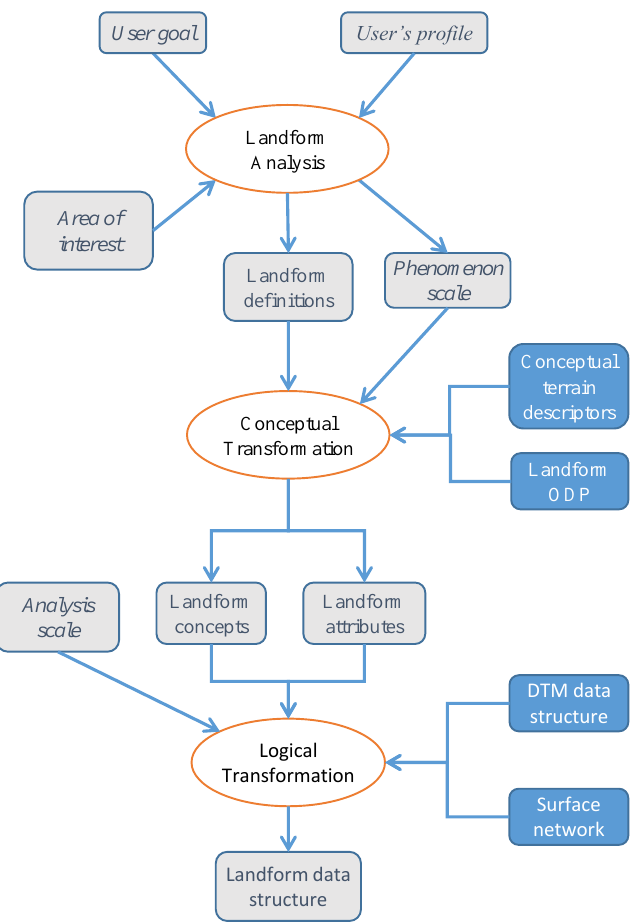
Figure 1. From landform definition to landform implementation. ODP, ontology design